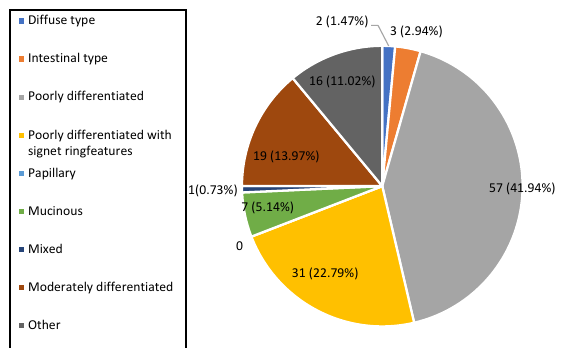
Figure 2. Percentage of Anatomical Exact Location Reports.